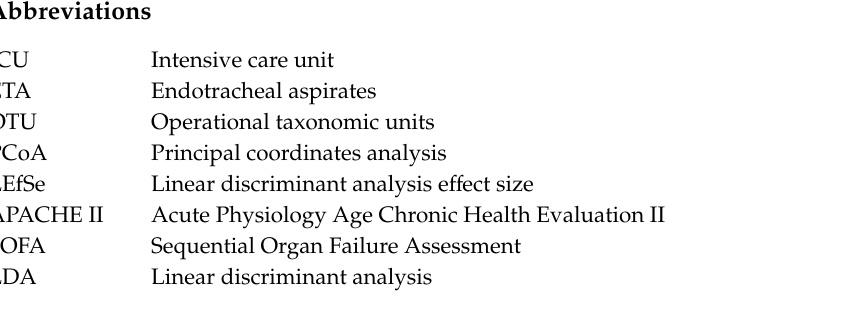
Figure S1: Predicted Kyoto Encyclopedia of Genes and Genomes pathways with a significant di ff erence in abundancebetweenthesuccessfulextubationgroup(Group1)andfailedextubationgroup(Group2). Thedi ff erence in mean proportions between groups was estimated using the Wilcoxon signed-rank